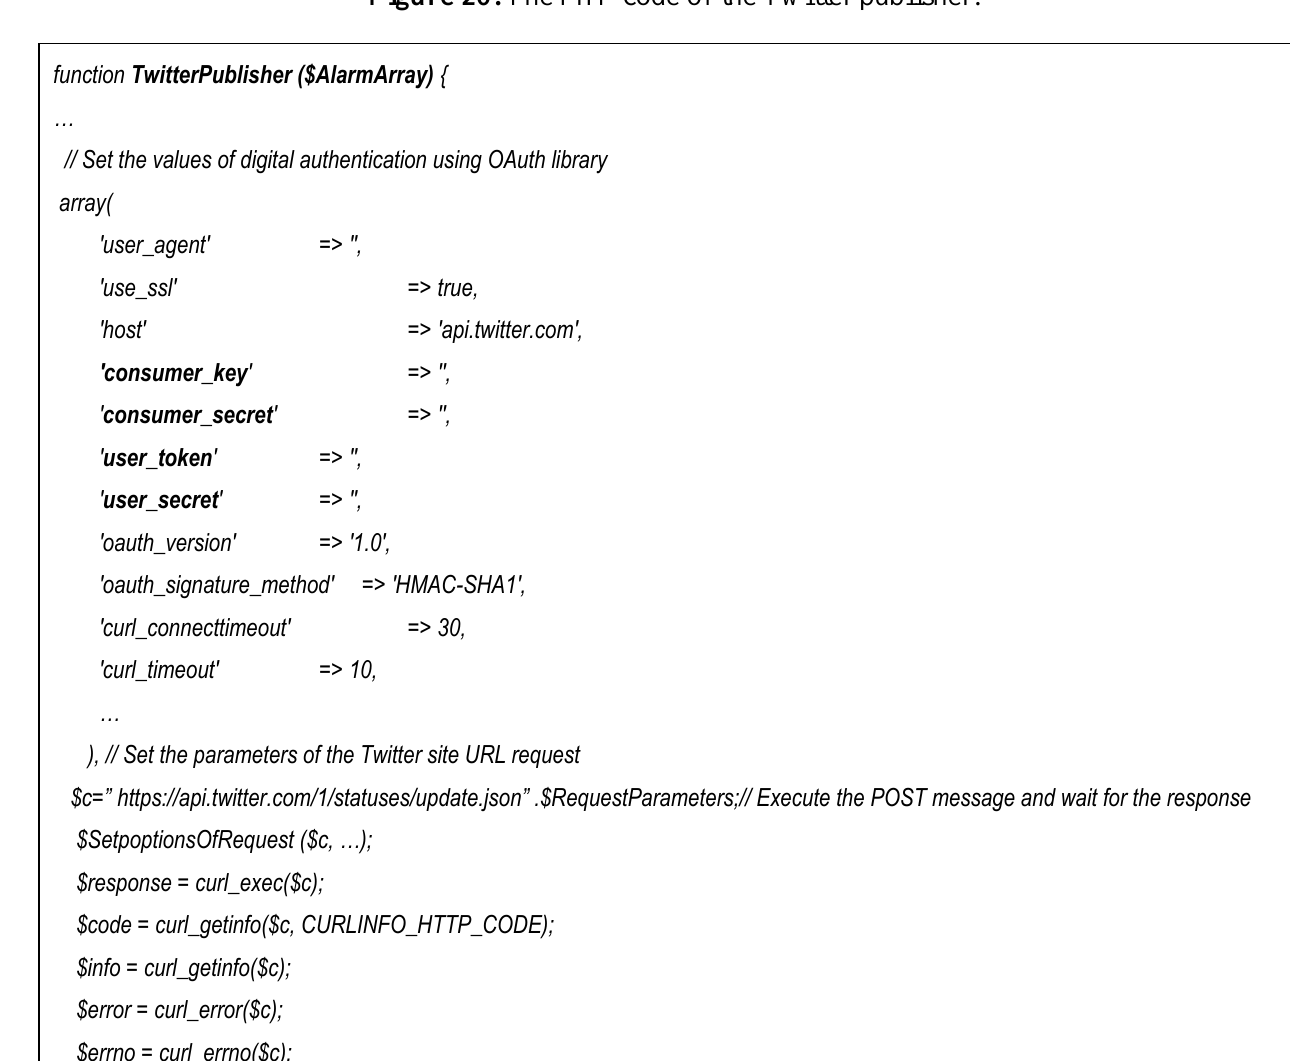
Figure 20. The PHP code of the Twitter publisher.